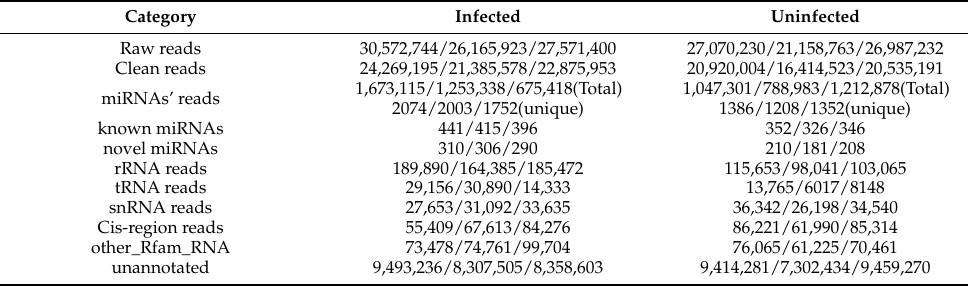
Table 2. Distribution of sRNAs in PEDV-infected and uninfected samples.